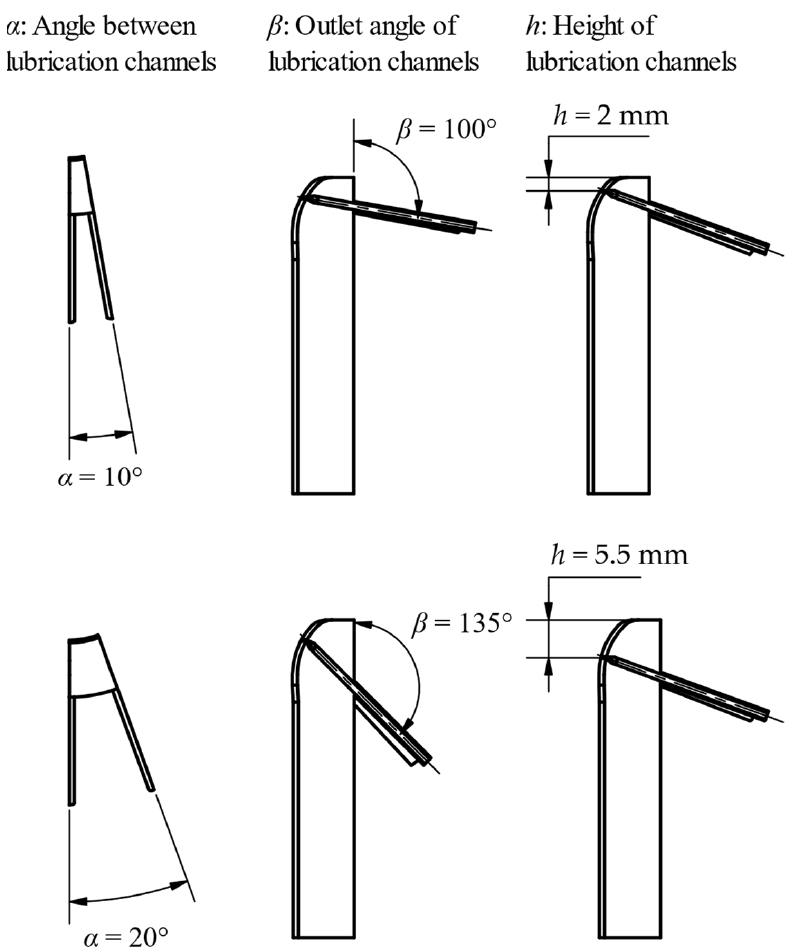
Figure 3. Outlet geometry parameters .